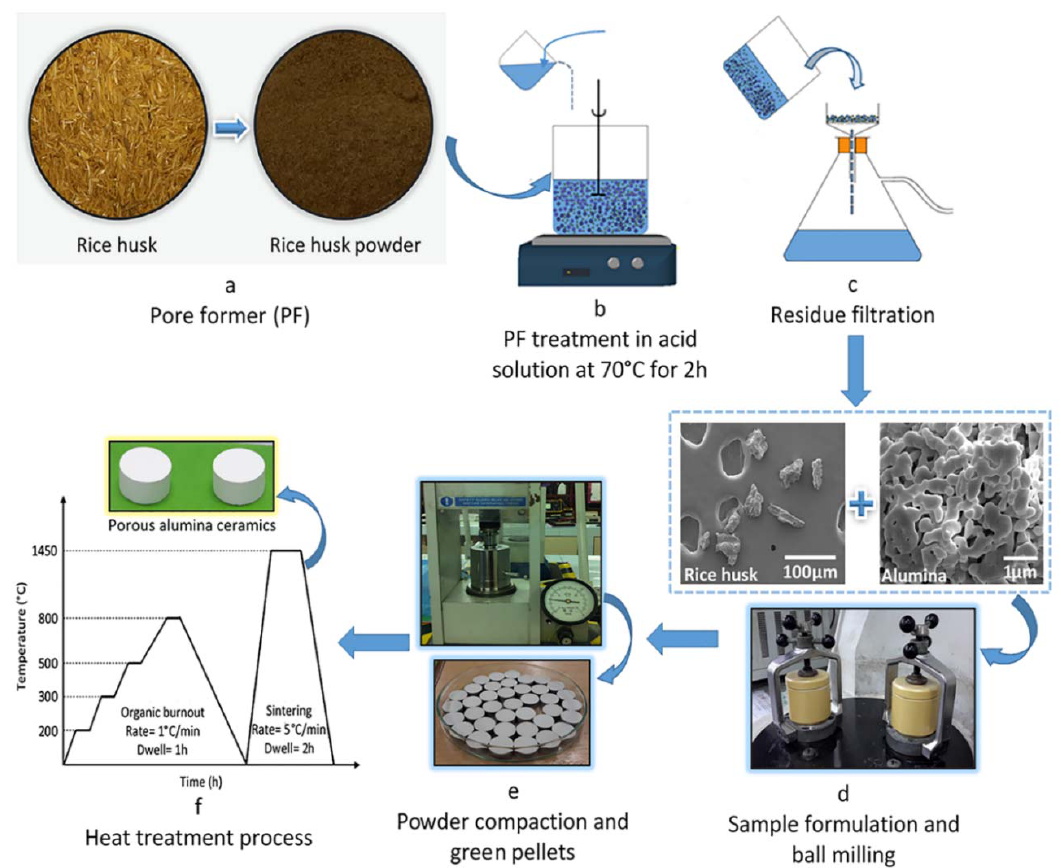
Figure 1. Schematic procedure for developing RH-shaped porous Al 2 O 3 ceramics.